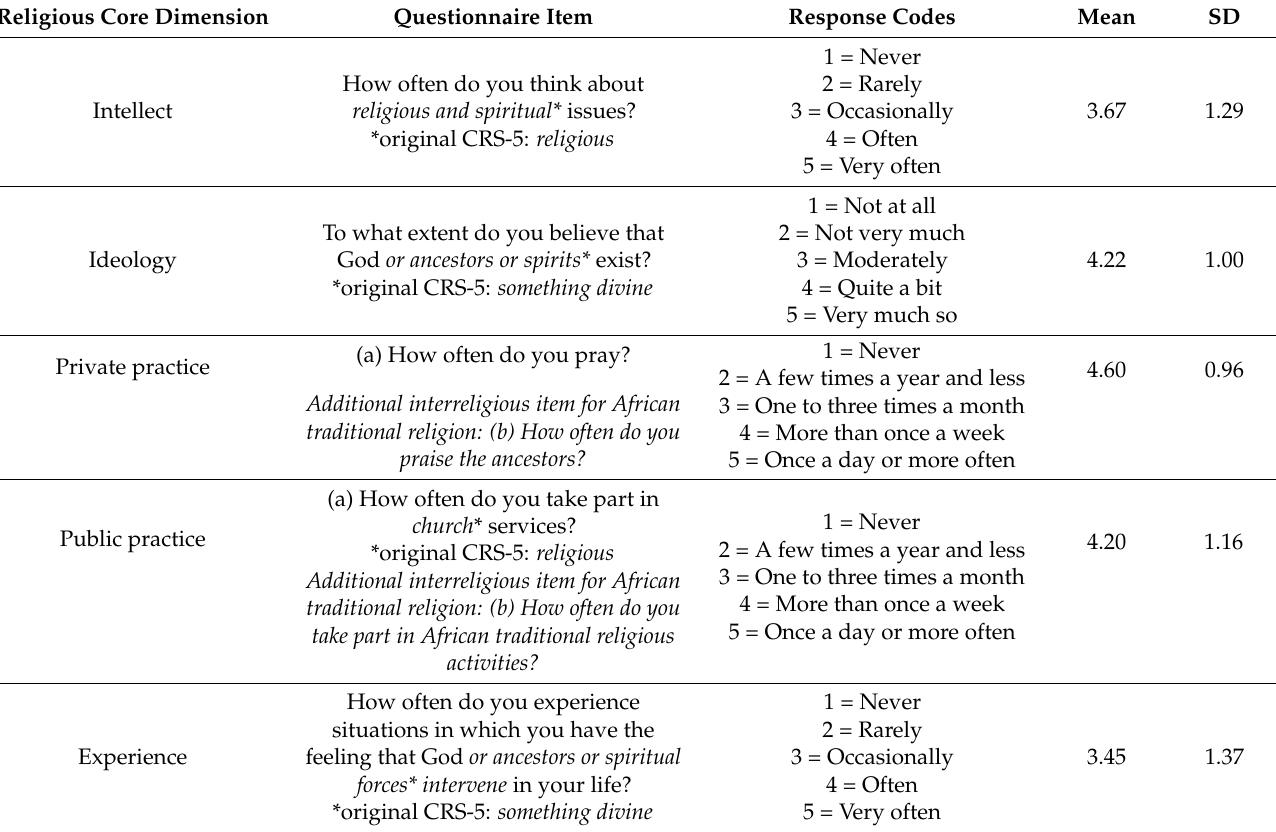
Table 3. Inventory of the Centrality of Religiosity